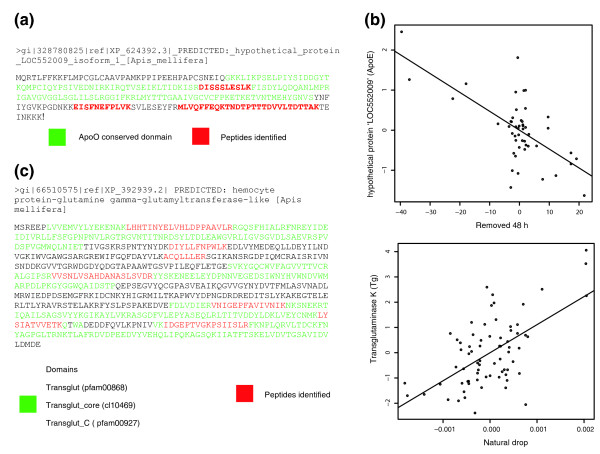
Protein sequence, peptide identification coverage, and conserved domains for two proteins with highly significant correlation with Varroa tolerant traits. (a-b) Sequence encodes a probable ApoO type protein found to correlate with hygienic behavior at 48 hours. (c-d) A transglutaminase (Tg) correlates with natural drops, an estimate of mite death rate in the colony. ApoO, apolipoprotein O.